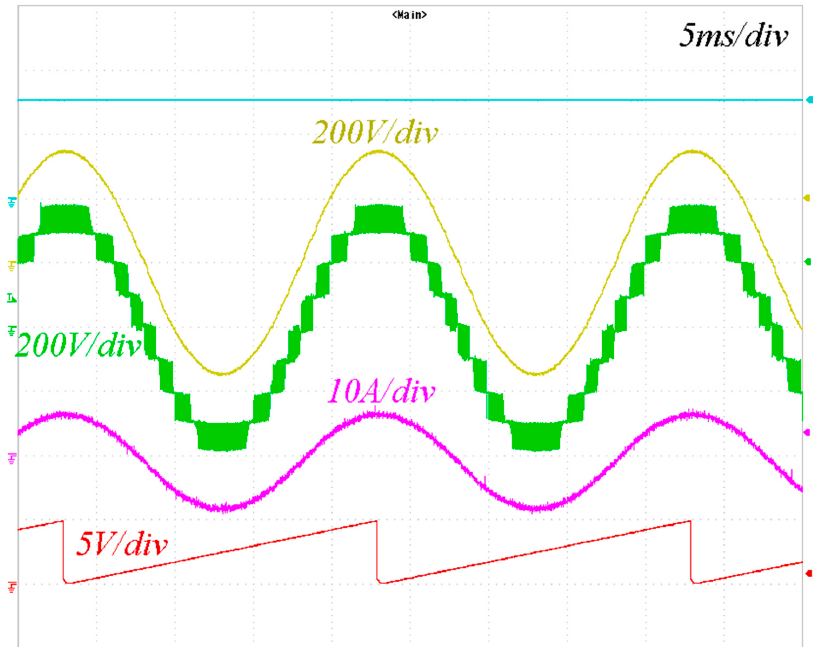
Figure 15. Grid side converter waveforms: fundamental component (yellow track), phase-to-neutral switching voltage u a(sw) (green track), grid current i a (magenta track), estimated grid angle (red track).